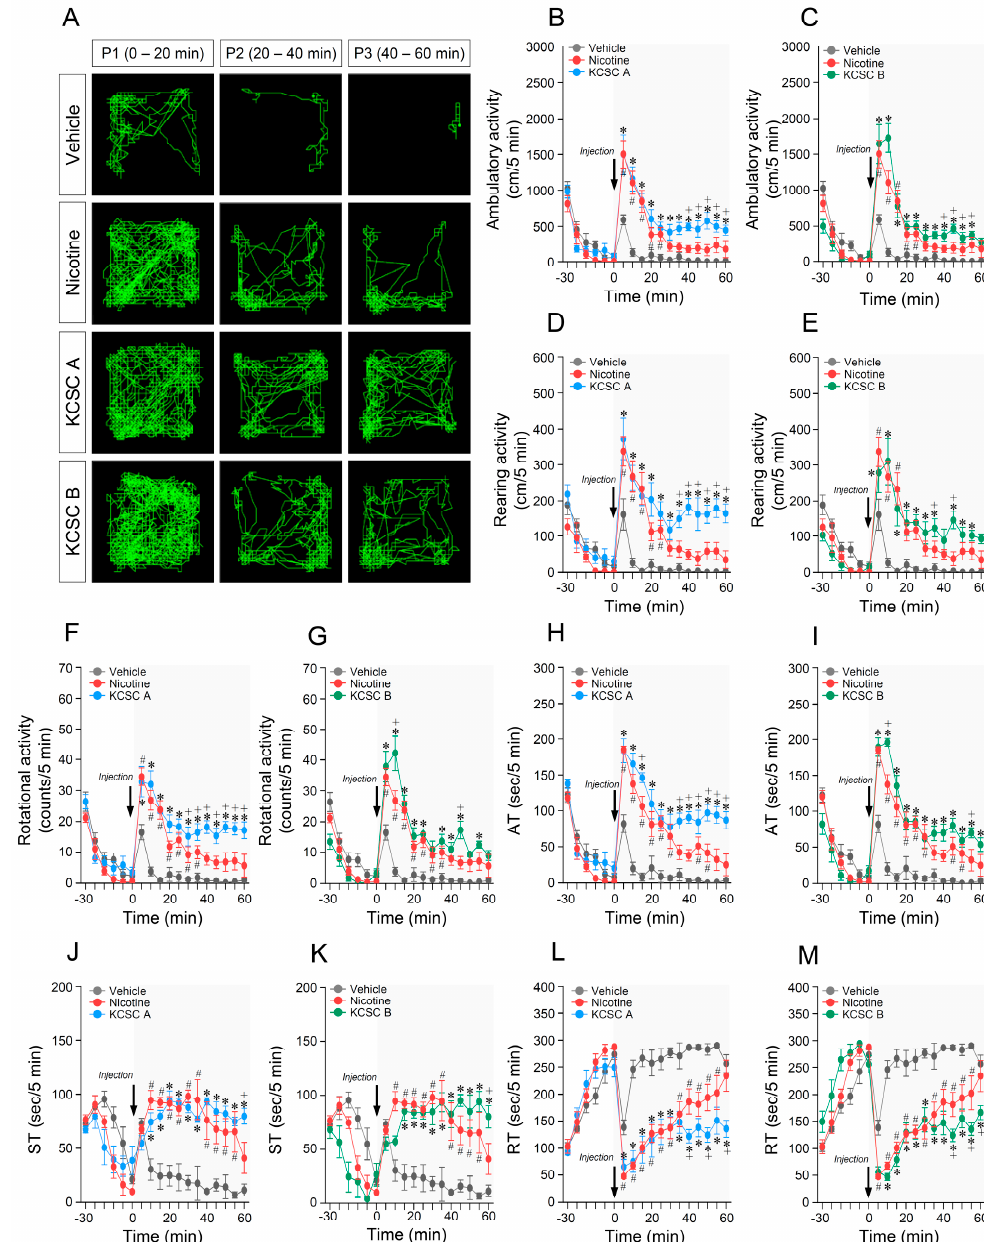
Figure 2. Prolonged changes in behavioral activities after repeated administration of two KCSCs for 14 days. Statistical significance was determined by two-way RM-ANOVA and multiple comparison test with Bonferroni’s post-hoc test. # p < 0.05, repeated vehicle group vs. repeated nicotine group; * p < 0.05, repeated vehicle group vs. repeated KCSC groups; + p < 0.05, repeated nicotine group vs. repeated KCSC groups. AT, ambulatory time; ST, stereotypy time; RT, resting time. n = 6 per group.